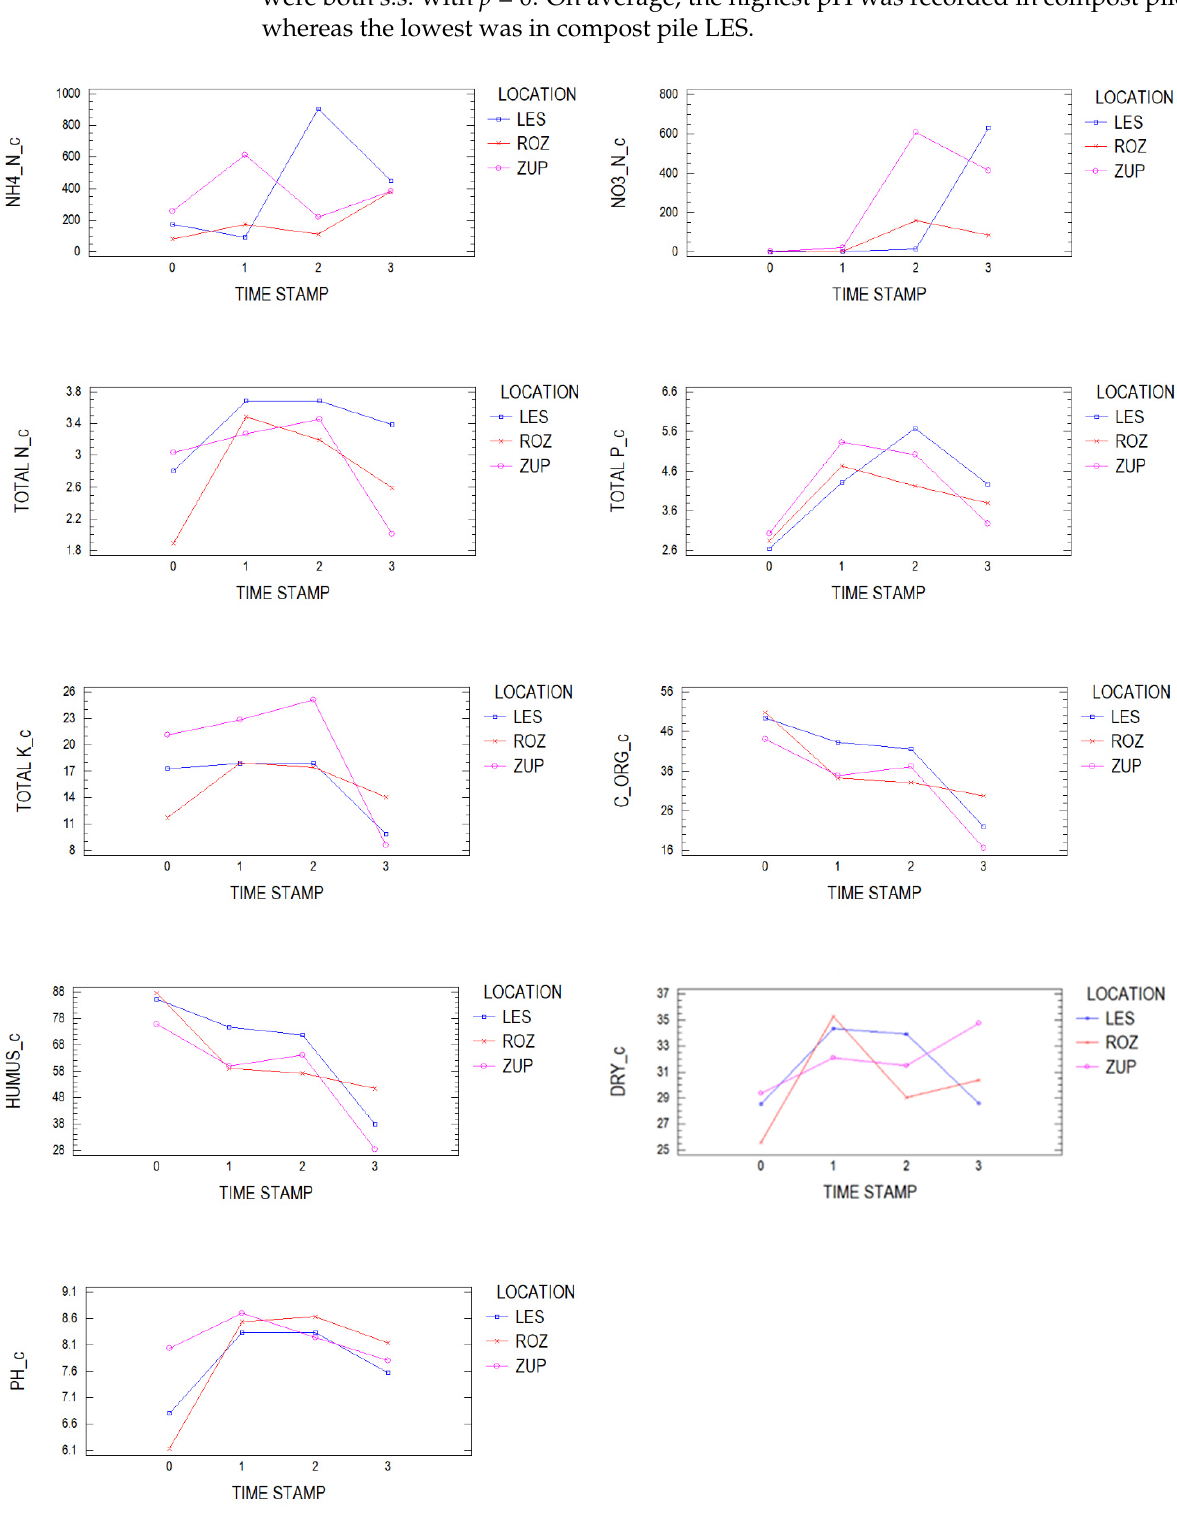
Figure 6. Biomass: Two-factor interactions.